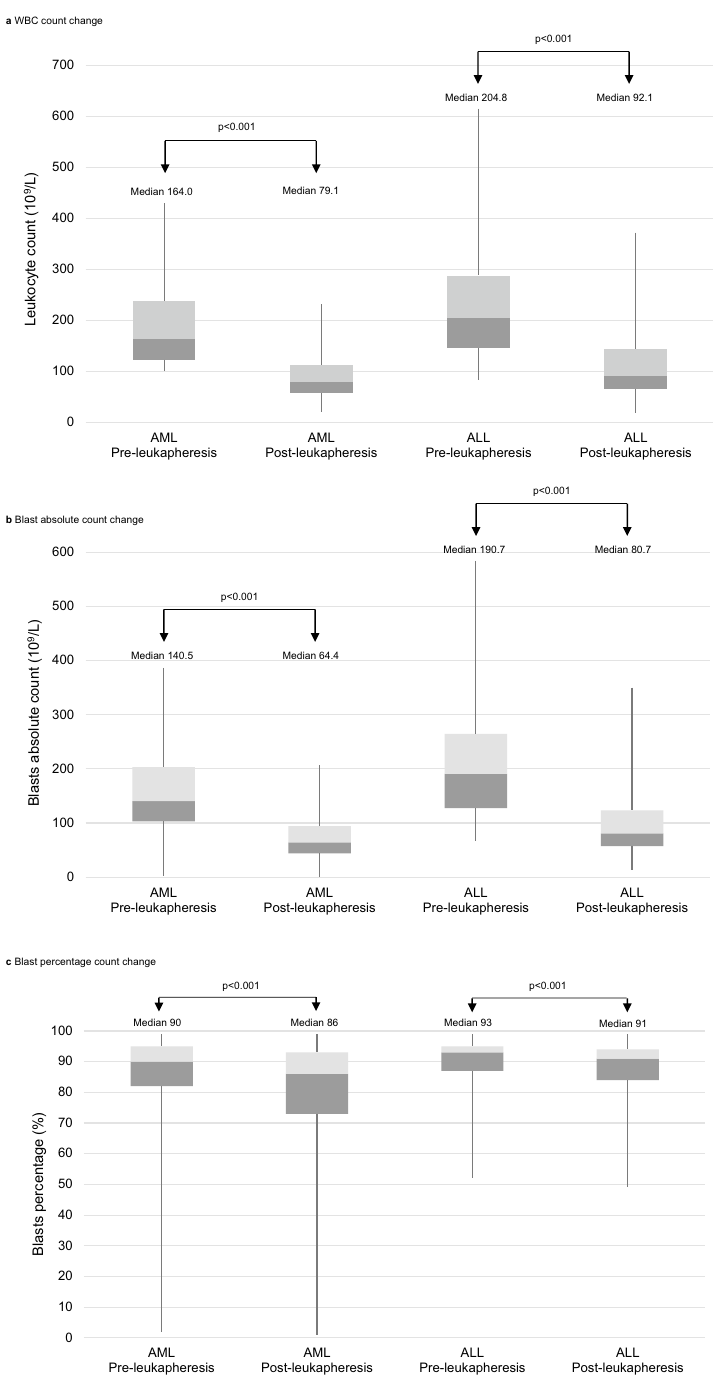
Figure 2. Changes in CBC parameters before and after leukapheresis in the acute myeloid leukaemia (AML) and acute lymphoblastic leukaemia (ALL) groups. Each boxplot represents the range from the 25th to 75th percentile of each group. CBC complete blood cell, WBC white blood